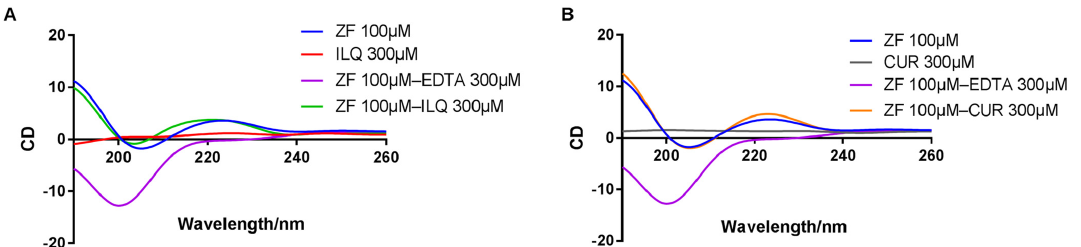
Figure 5. Characterization of the ZF structure upon ILQ or CUR binding. ( A ) CD spectra of ZF at t = 2 h from the incubation with ILQ at 3:1 ([ILQ]/[ZF]) ( B ) CD spectra of ZF after the incubation with CUR for 2 h at 3:1 ([CUR]/[ZF]).